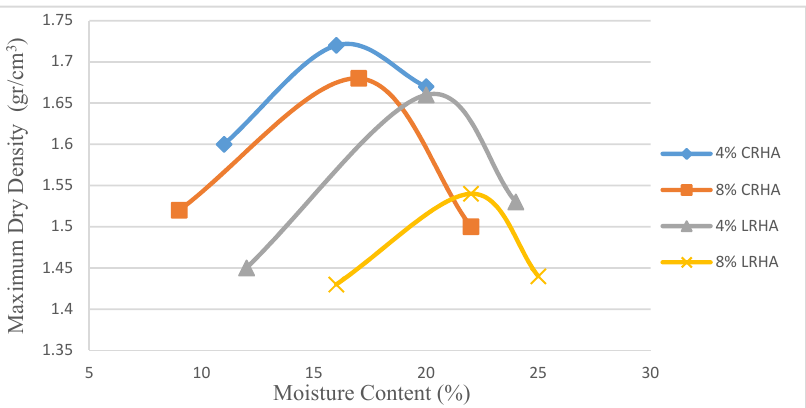
Figure 5. Maximum dry density ( γ dmax) based on stabilizer contents (1:2)